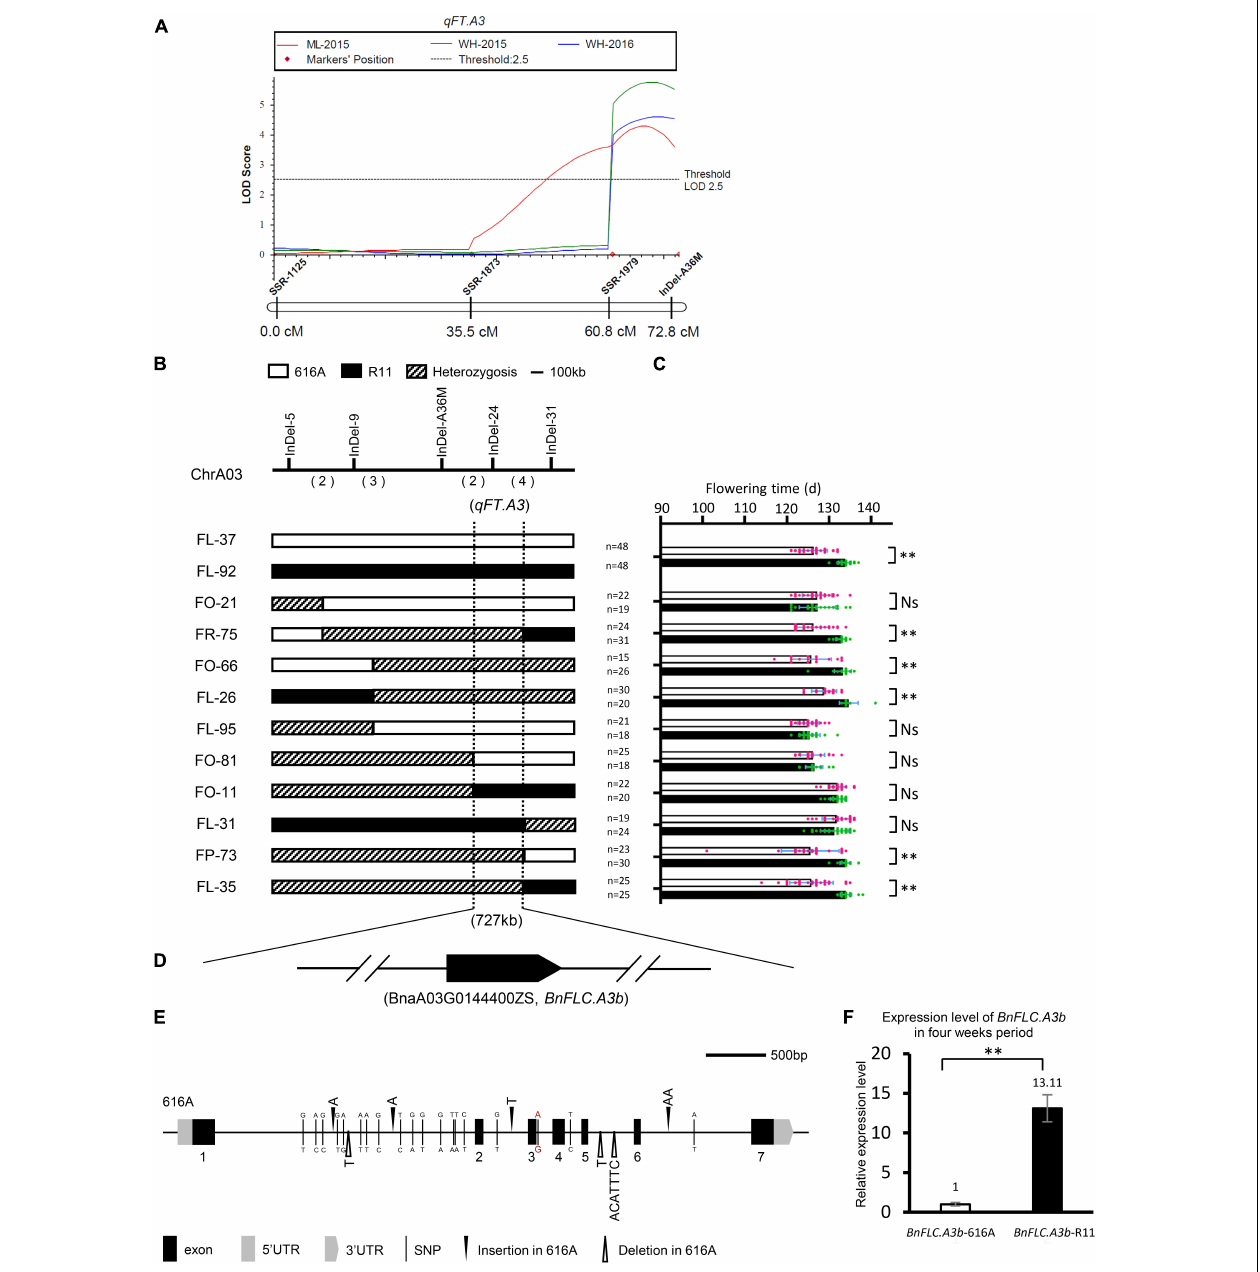
FIGURE 2 | Qualitative trait locus (QTL) mapping of qFT.A3 . (A) Partial linkage map of chromosome A03 and QTL scanning of qFT.A3 . (B) Genotype of the recombinants in the BC 2 F 3 population. The numbers in parenthesis indicate the number of crossovers. (C) Progeny testing of two near-isogenic lines (NILs) and 10 recombinants narrowed qFT.A3 to a region of 727 kb. Hollow bars indicate the phenotype of 616A homozygous segments and solid bars indicate the phenotype of R11 homozygous segments. Data represent mean ± SD. NS, not significant; ∗∗ , significant at p < 0.01. (D) Annotated flowering time genes identified in the qFT.A3 locus. Arrow indicated the direction of transcription; the break line indicated other genes not annotated for flowering time. (E) Sequence variations of the coding region of BnFLC.A3b in 616A and R11. The single nucleotide polymorphism and insertion/deletion variations between R11 and 616A were indicated by the benchmark of 616A. The red color indicated the G to A mutation of the five prime splicing sites between R11 and 616A. (F) Expression levels of BnFLC.A3b in 616A and R11, three biological replicates, and three technical replicates.